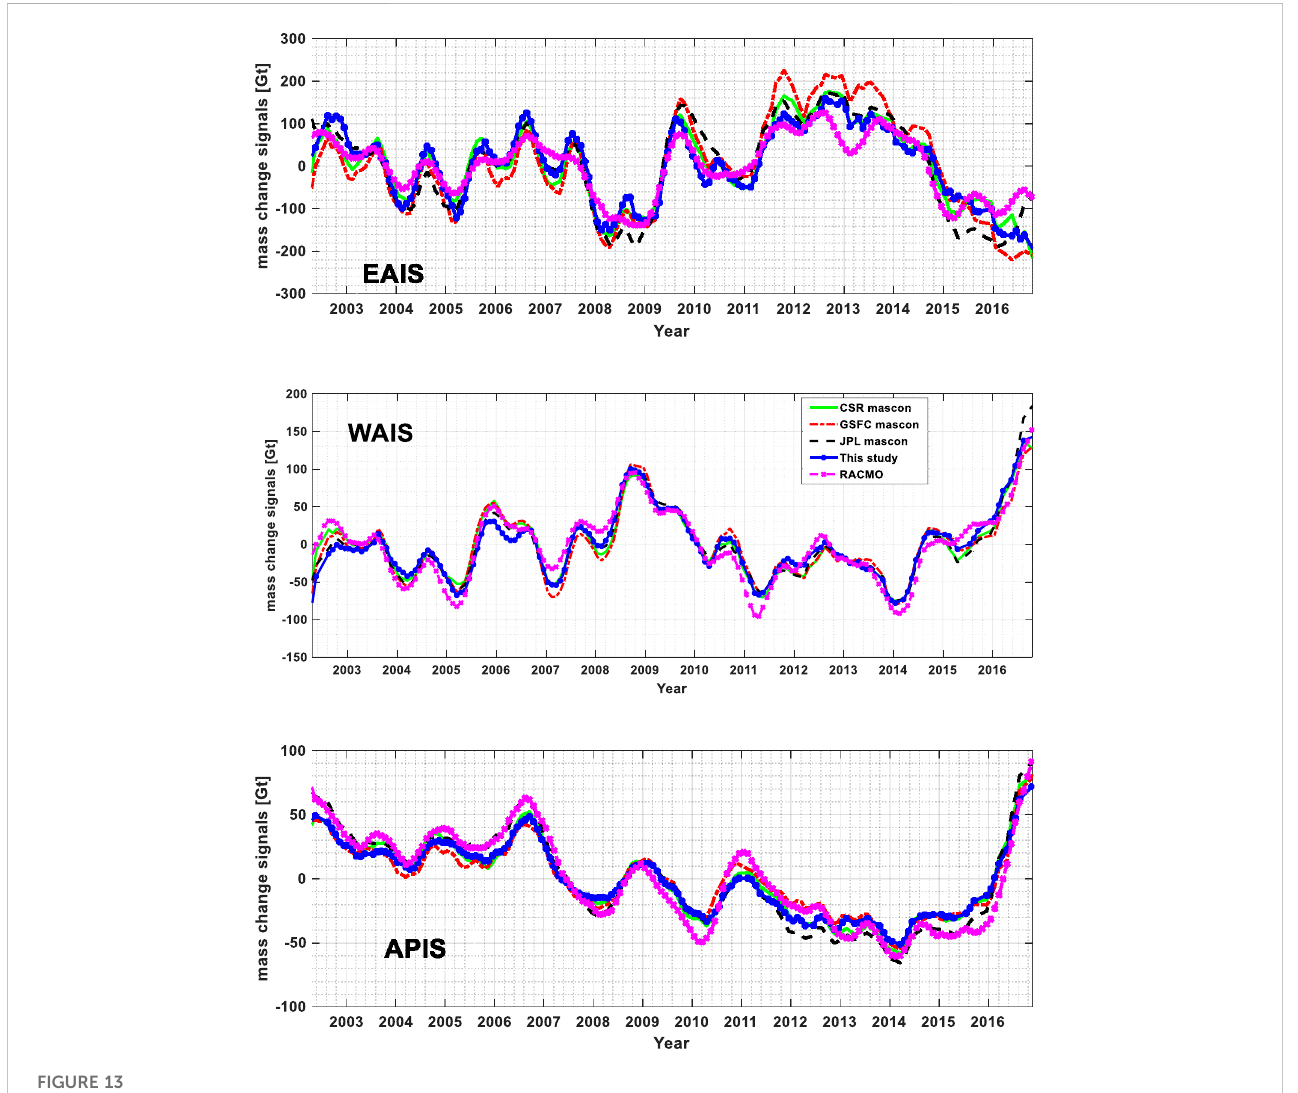
FIGURE 13 Detrend and smoothed mass change signals of four mascon solutions and cumulative